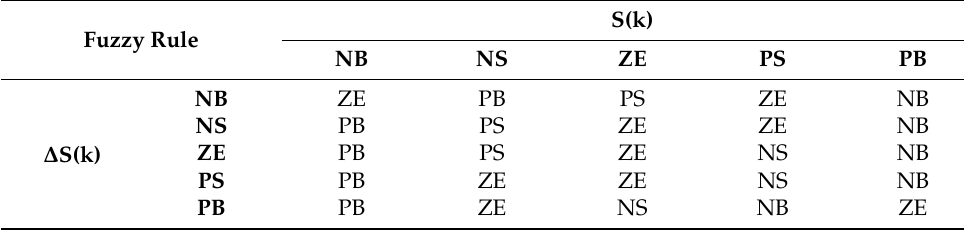
Figure 6. Fuzzy logic membership functions. Table 1. Fuzzy rule table based on